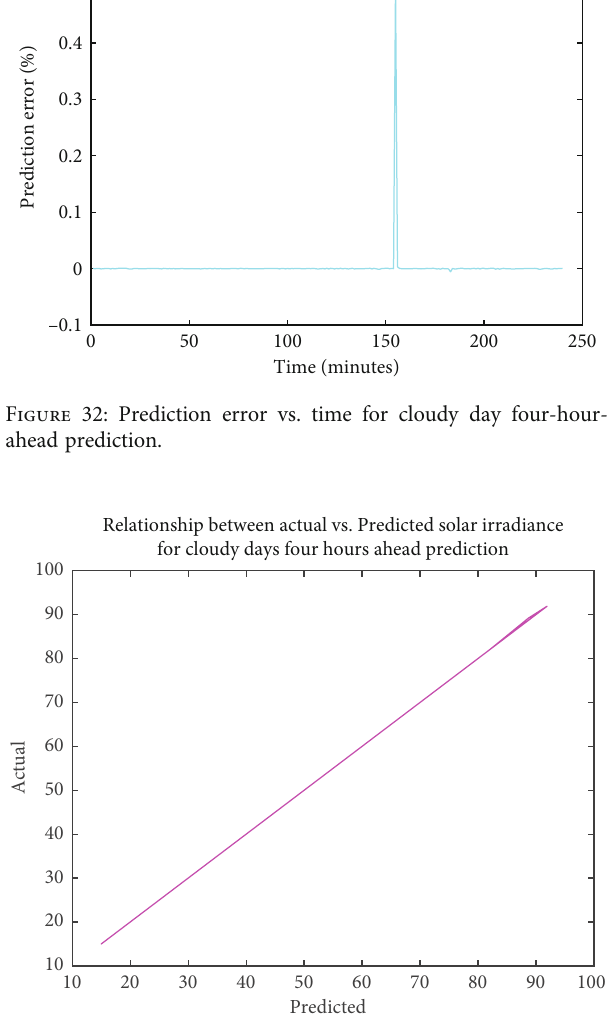
Figure 33: Relationship between actual vs. predicted solar irradiance for cloudy day four-hour-ahead